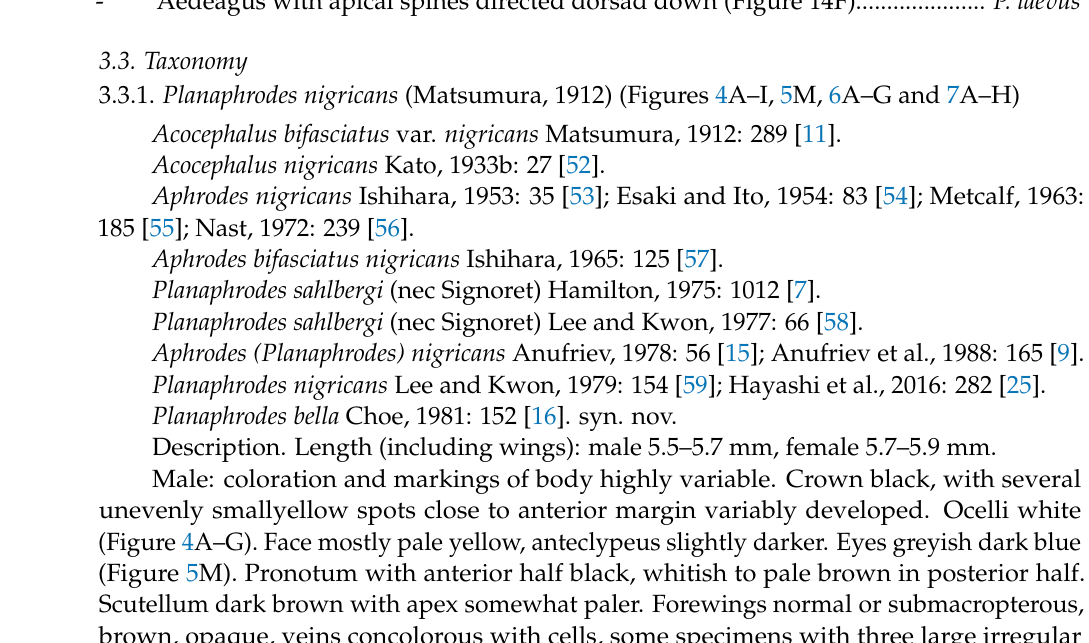
(Figure 5M). Pronotum with anterior half black, whitish to pale brown in posterior